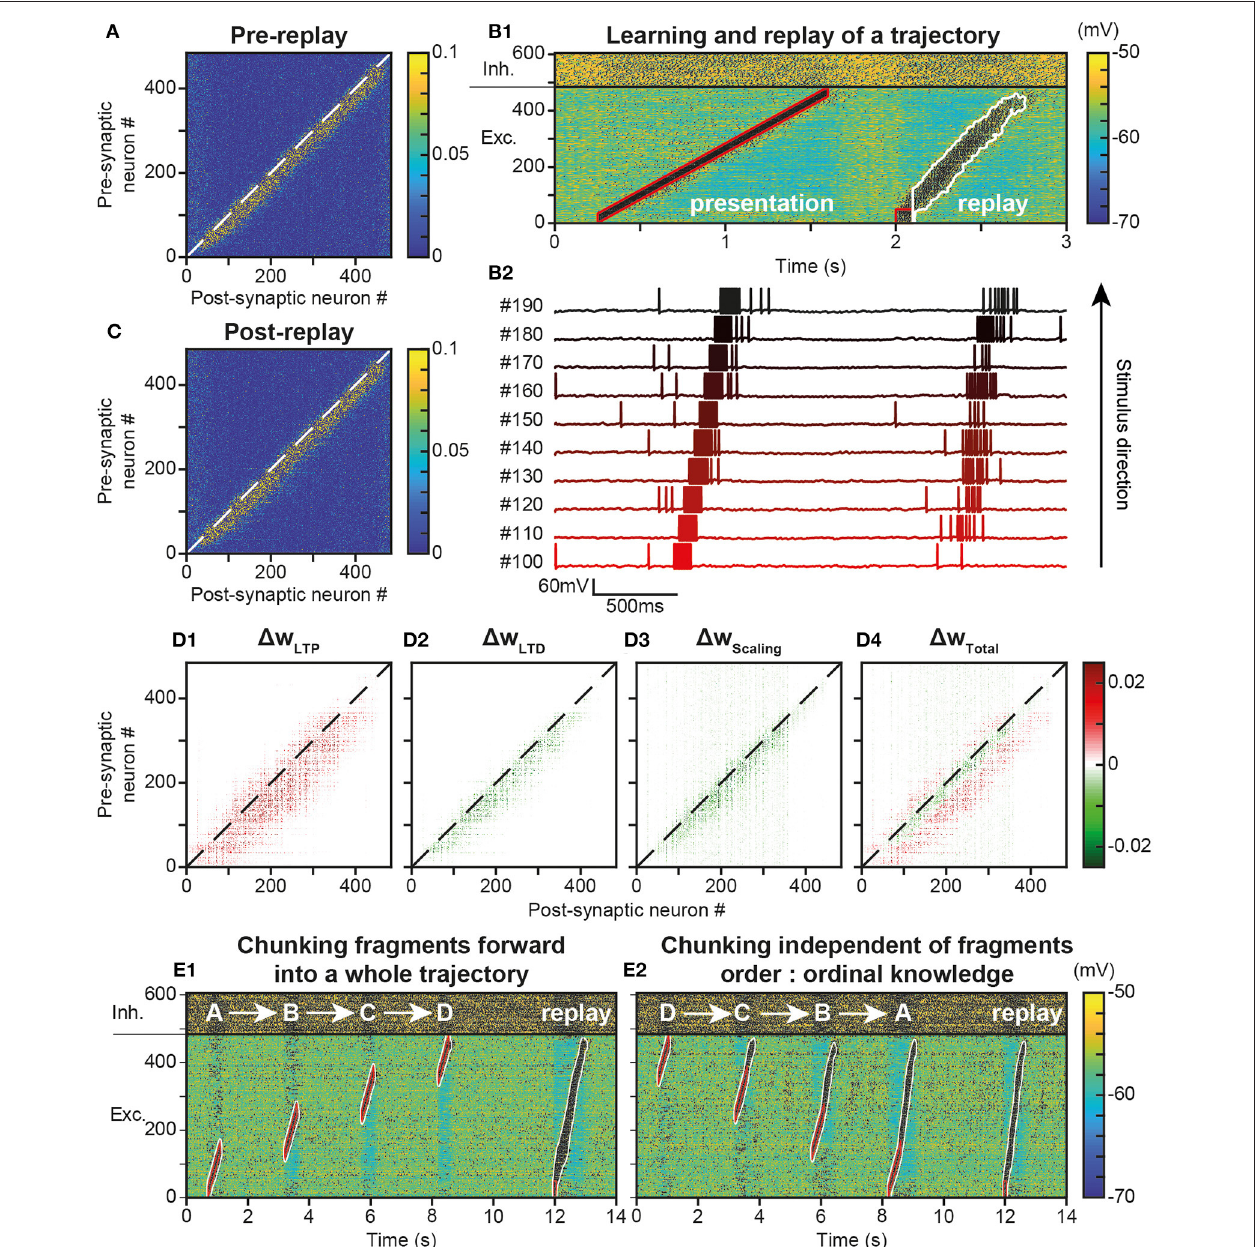
FIGURE 4 | Replay of learned trajectories. (A) . Synaptic matrix between excitatory neurons after stimulus presentation but prior to trajectory replay. (B) . Membrane potential of network neurons ( B1 , spikes indicated by black dots) in response to the trajectory stimulus, followed by a transient trajectory replay triggered by stimulating the start of the trajectory (neurons #1–50, stimulus in red). Membrane potential of a selected subset of neurons along the trajectory ( B2 , arbitrary colors). (C) . Synaptic matrix between excitatory neurons after stimulus and replay. (D) . Weight modifications resulting, after compared to before trajectory replay, from t-LTP (D1) , t-LTD (D2) , scaling (D3) , and their sum (D4) . (E) Recapitulation of the whole trajectory after separately learning four individual trajectory fragments (ABCD) in the forward order ( E1 ; chunking) or backward order ( E2 ; ordinal knowledge). Each fragment corresponds to 180 neurons. Fragments overlap over 65